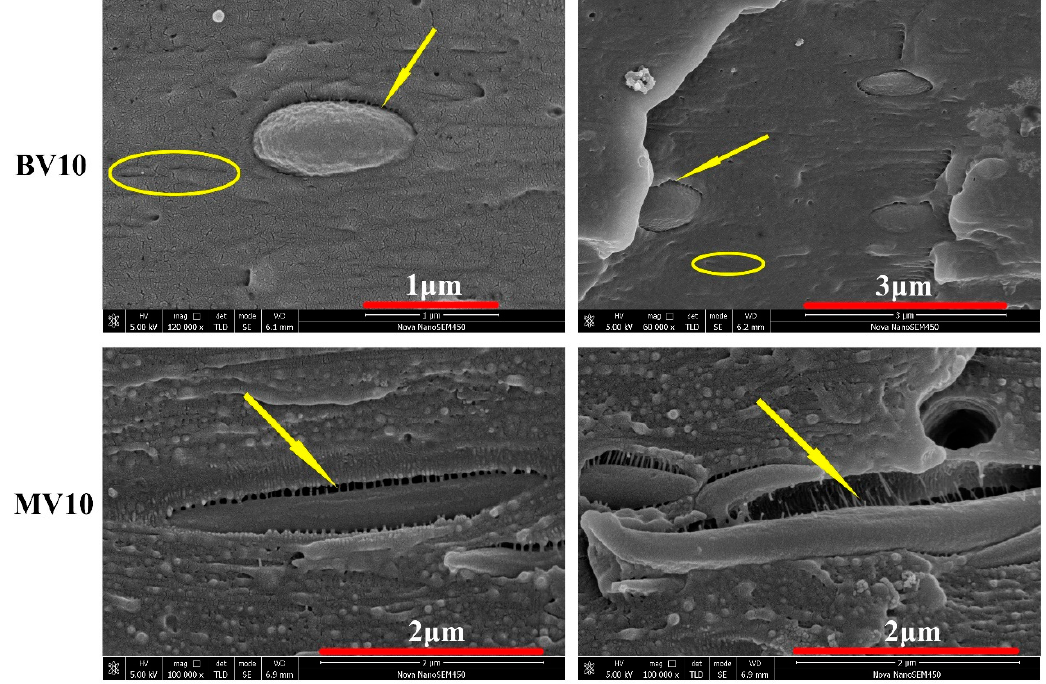
Figure 9. Core–shell structures. Arrows indicate POE ‐ g ‐ MA removed by n ‐ heptane.